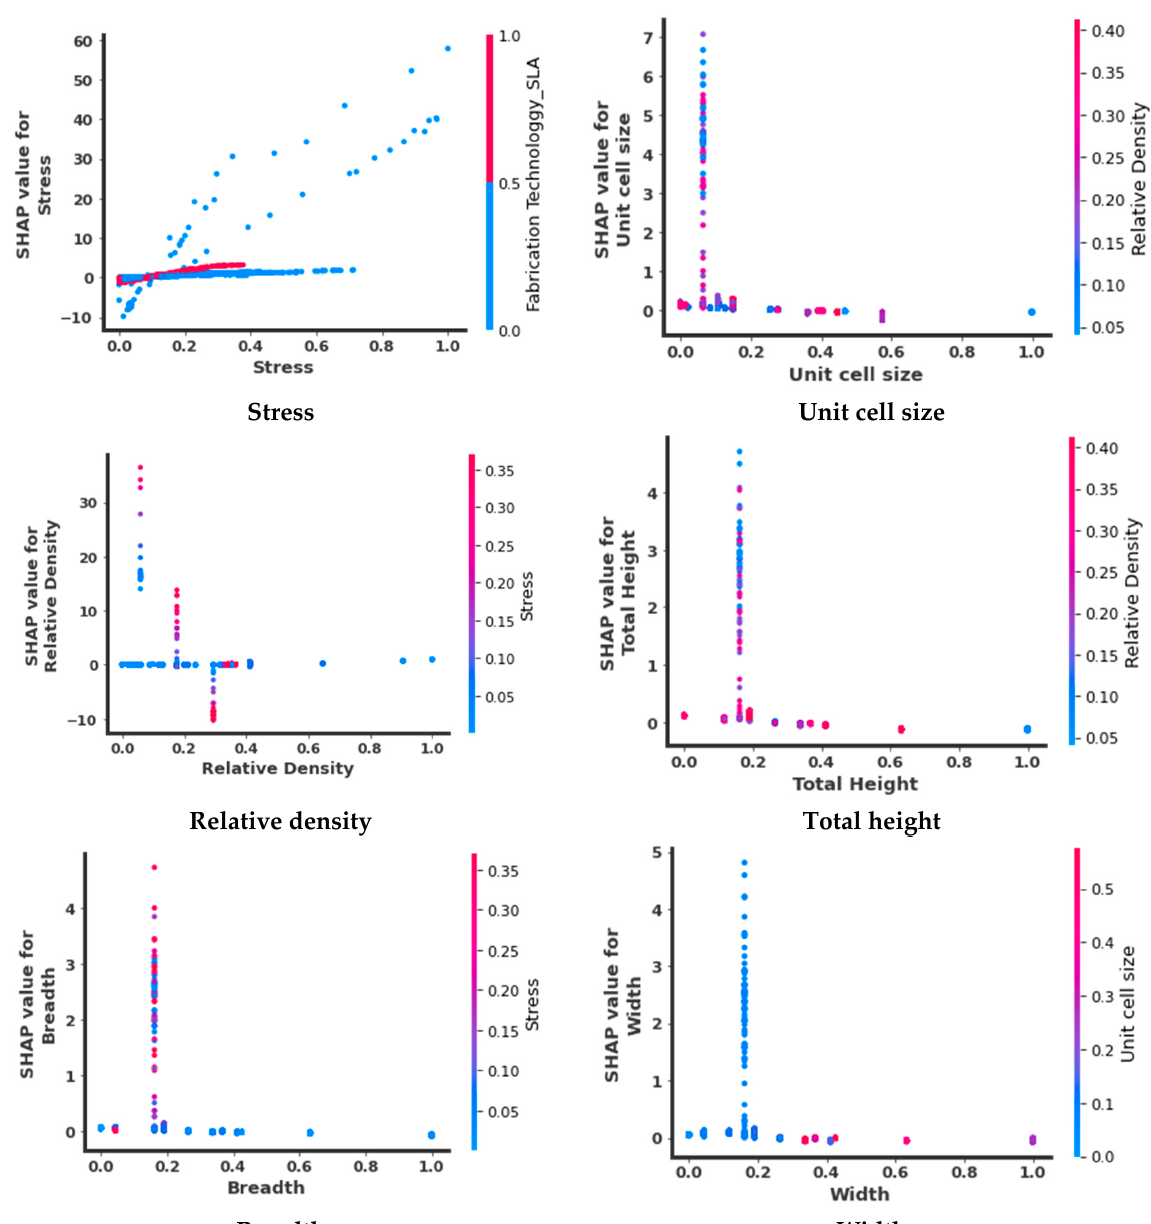
Figure 11. Dependence plots to interpret the predictions of the DL model.